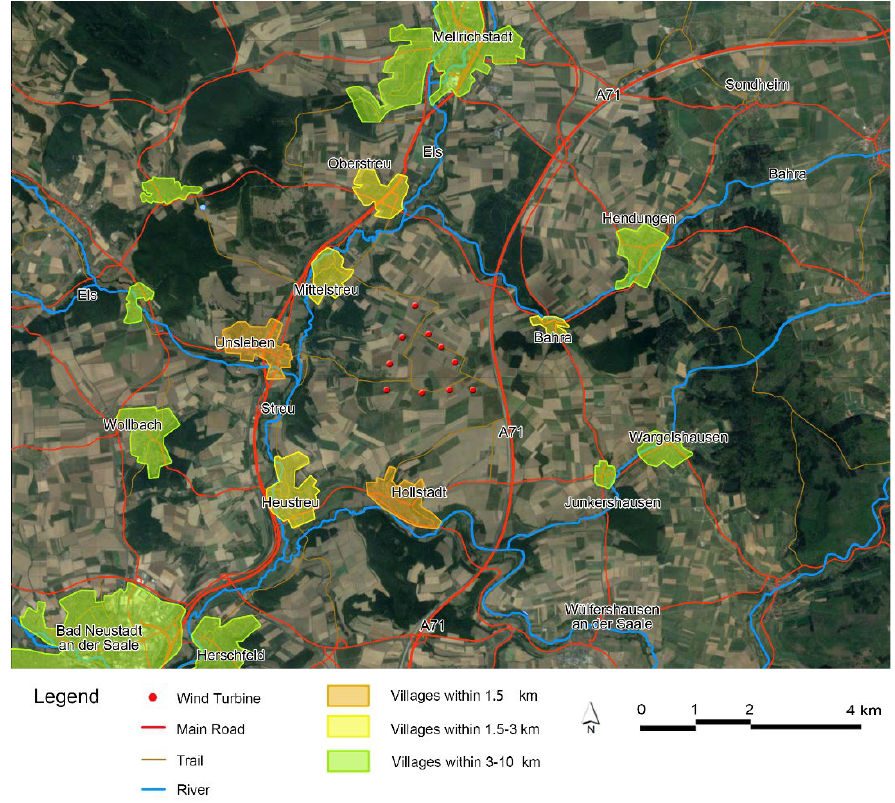
Figure 3. Master plan of Friedrich‑Wilhelm Raiffeisen Wind Farm Streu & Saale. (Source: drawn by the author).